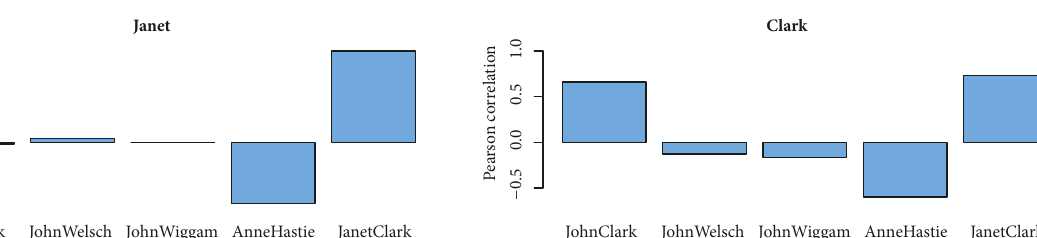
Figure10:Correlationsofestimatedsemanticvectorsfor John , JohnWelsch , Janet ,and Clark withthetargetedsemanticvectorsofJohnClark, JohnWelsch, JohnWiggam, AnneHastie, and